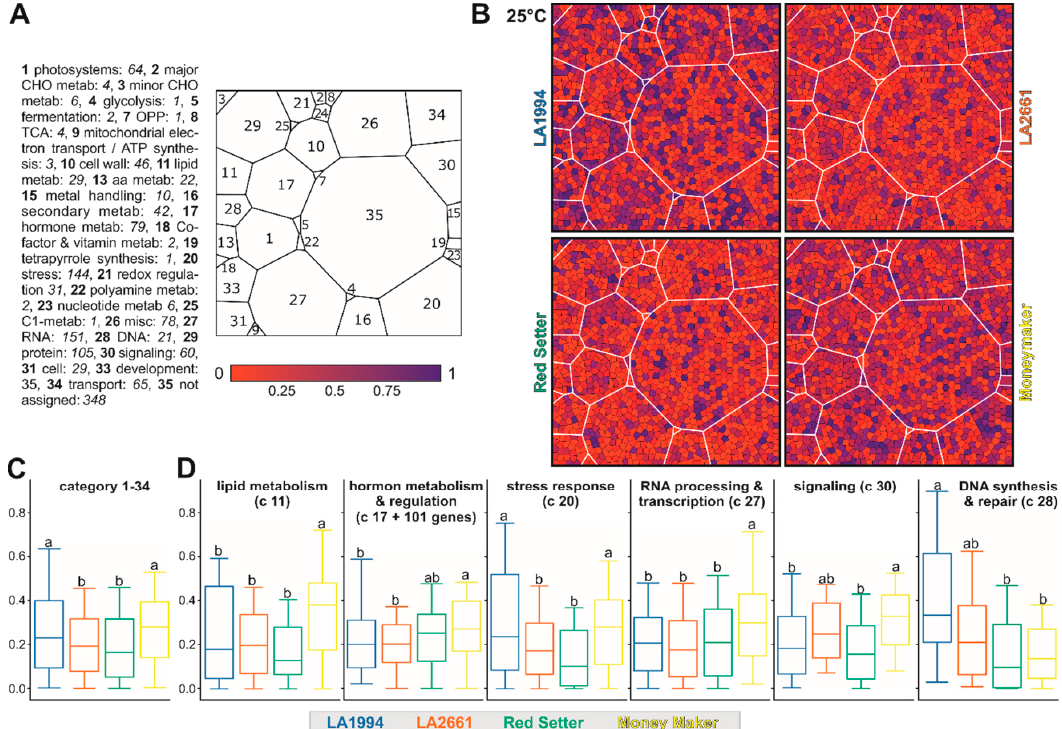
11 of 21 Figure 4, orange circle) or Red Setter/LA1994 (PC2, Figure 4). PC3 and PC4 separate Moneymaker